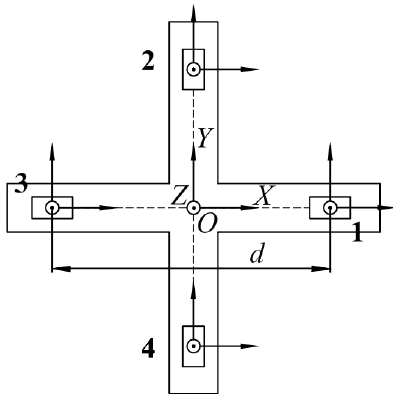
Figure 1. Structural design of the planar cross-magnetic gradient tensor system.